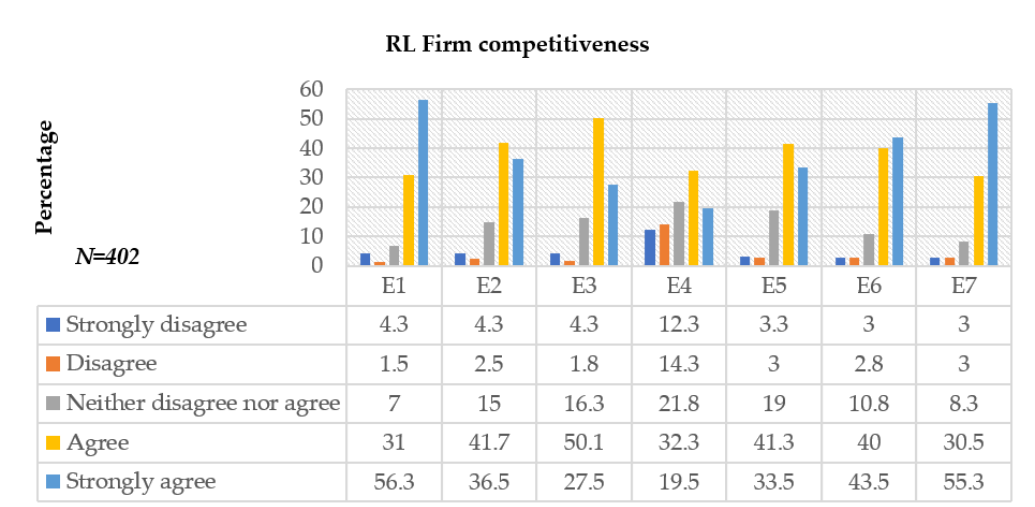
Figure 4. RL firms ’ competitiveness based on customers. E1 = The FMCG retailers should provide products of high quality; E2 = The FMCG retailers should provide lower and affordable product prices; E3 = We could get better product value from our FMCG retail firms’ ability to recycle products; E4 = Changing the packaging of returned damaged products and selling them to second-hand markets can help the FMCG retailers improve their product image in the market; E5 = Having a product returns policy has helped the FMCG retailers improve their image in the market; E6 = Having a separate unit that deals with the returned products could help the FMCG retailers improve their service to customers; E7 = Having dedicated staff to handle customer’s complaints can help the FMCG retailers improve customer satisfaction.